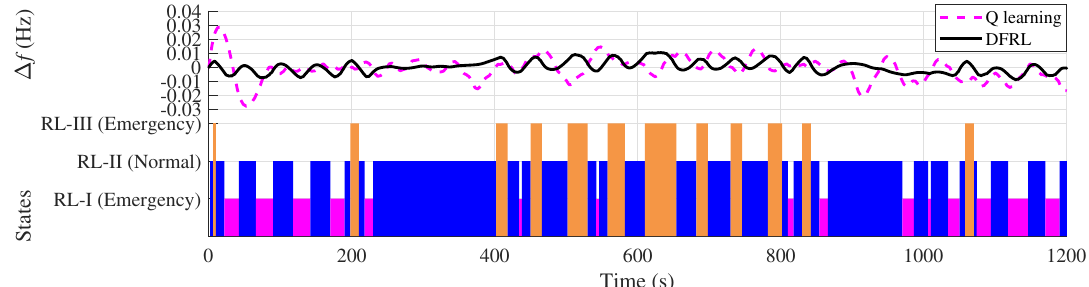
Figure 10. Next states of the three-area power system in Case